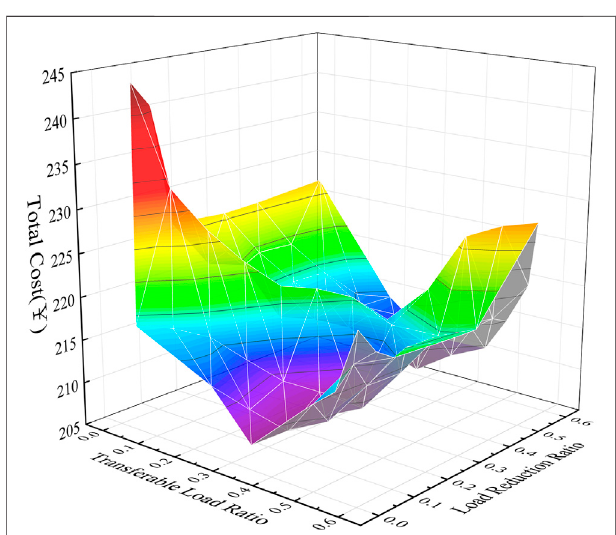
FIGURE 13 | The relationship between demand response load proportional coef fi cient and